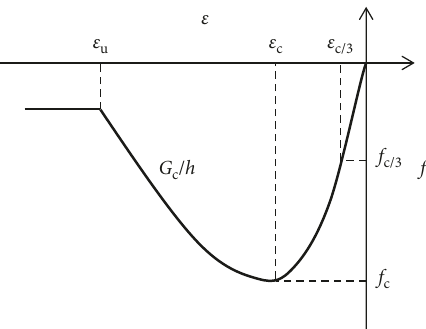
Figure 10: Compressive model with parabolic hardening-